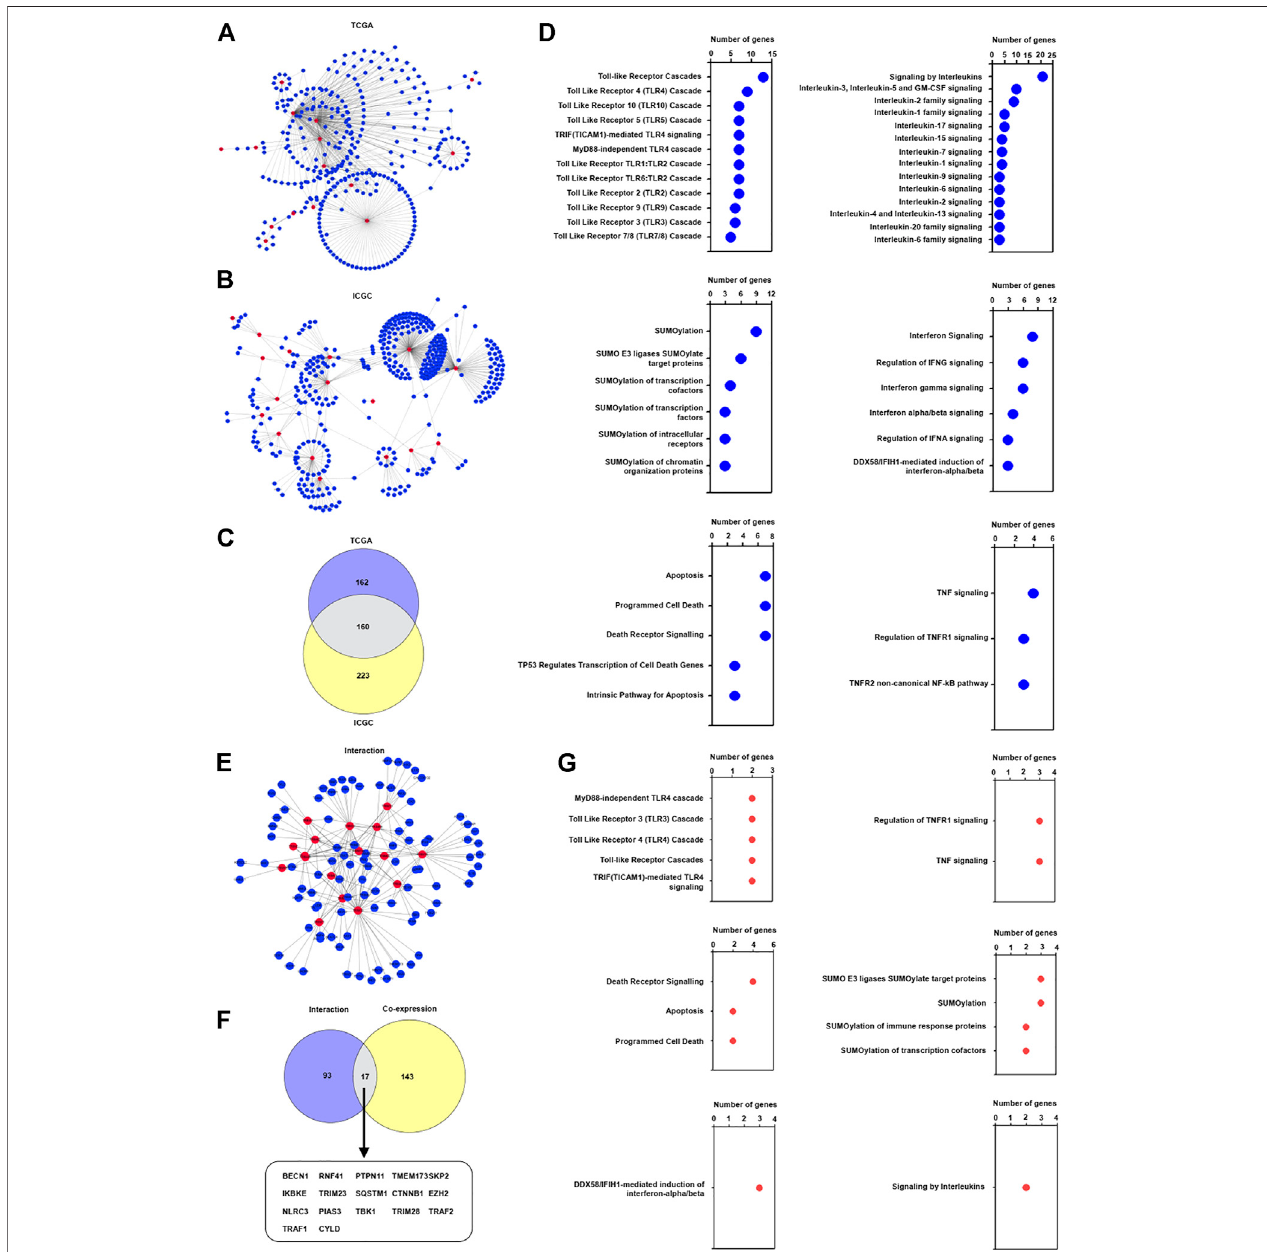
FIGURE 3 | The correlation of TRIMs with innate immune genes in HBV-positive HCC. (A) The co-expression pattern of innate immune genes with 17 TRIMs in HBV-positive HCC in TCGA cohort. (B) The co-expression pattern of innate immune genes with 17 TRIMs in HBV-positive HCC in ICGC cohort. (C) The common co- expressed innateimmunegeneswithidenti fi edTRIMsinHBV-associatedHCCinbothTCGAandICGCcohorts. (D) ThetermsofReactomepathwayanalysisrelatedto the common innate immune genes. (E) The interaction of 17 TRIMs with identi fi ed innate immune genes. (F) The common genes between the co-expressed and interacted innate immune genes. (G) The terms of Reactome pathway analysis related to the common innate immune genes.